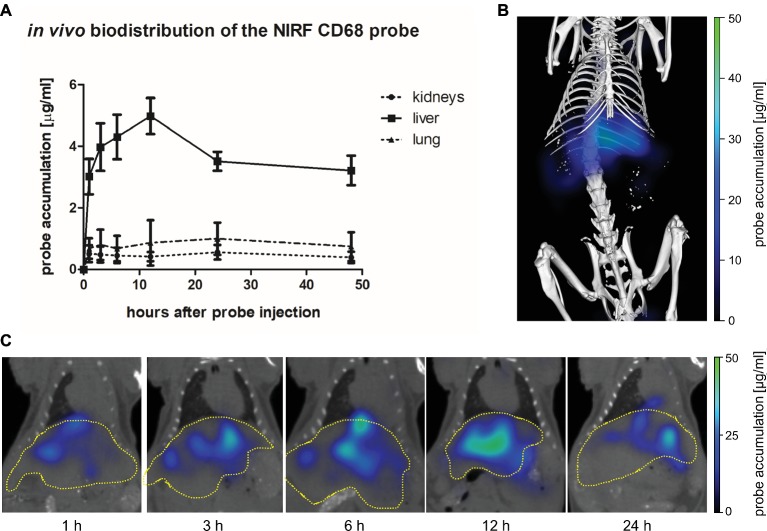
In vivo biodistribution of the NIRF CD68 probe. To analyze the biodistribution of the NIRF CD68 probe, the accumulation in different organs was measured longitudinally over 48 h in healthy mice by FMT-μCT. (A) Quantitative analysis of the NIRF CD68 probe concentration in the kidneys, liver, and lung revealed a significantly higher concentration in the liver compared to the kidneys and the lung at all measuring time points (p < 0.001 for each time point, data are presented as mean values ± SD). (B) Representative 3D rendering of reconstructed FMT-μCT data of a mouse 12 h after NIRF CD68 probe injection. (C) Representative frontal plane images of reconstructed FMT-μCT data at different time points after NIRF CD68 probe injection show an increasing fluorescent signal intensity in the liver until 12 h after injection, followed by a decline (dashed yellow line indicates the liver).